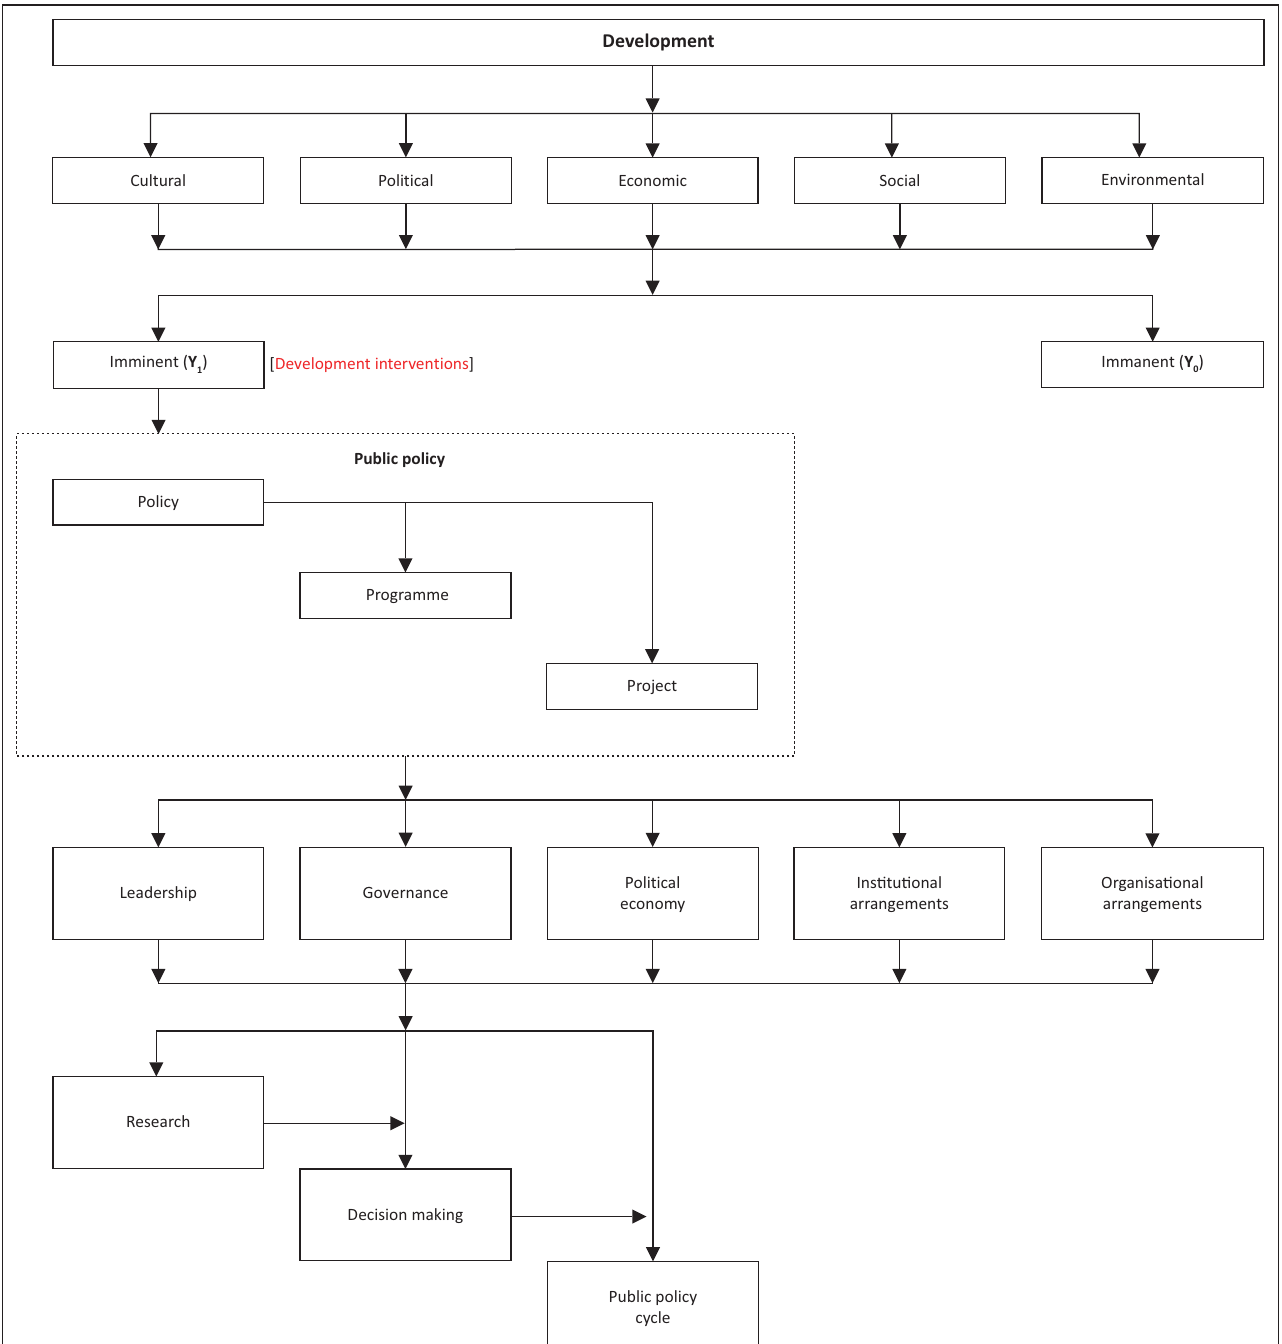
FIGURE 5: Illustrating the relationship between development (and its components and processes) and public policy (and its components and